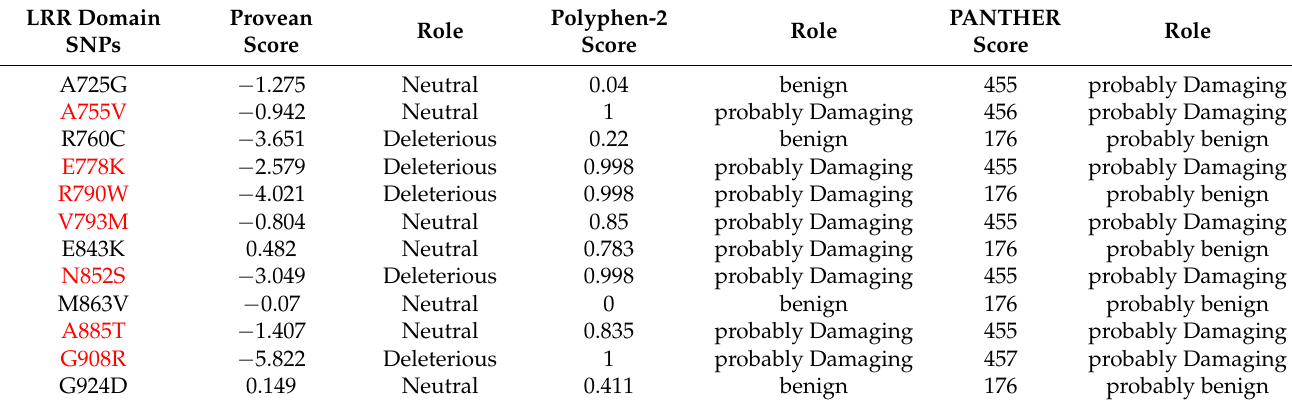
Figure 3. Evolutionary conservancy of the NOD2 LRR domain in the mutated positions. The image was produced by Consurf [87]. Table 2. Characterization of functionality of SNPs using sequence homology tools. The SNPs in red are predicted to be damaging by at least two of the computational homology